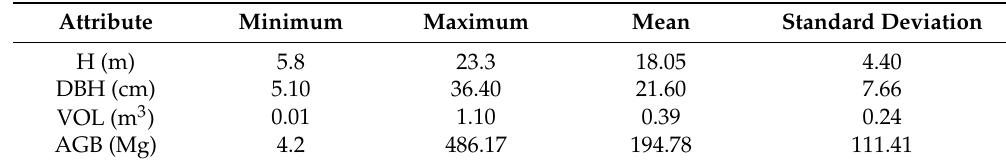
Table 1. The descriptive statistics of reference trees; height (H), DBH (DBH), stem volume (VOL), and aboveground biomass